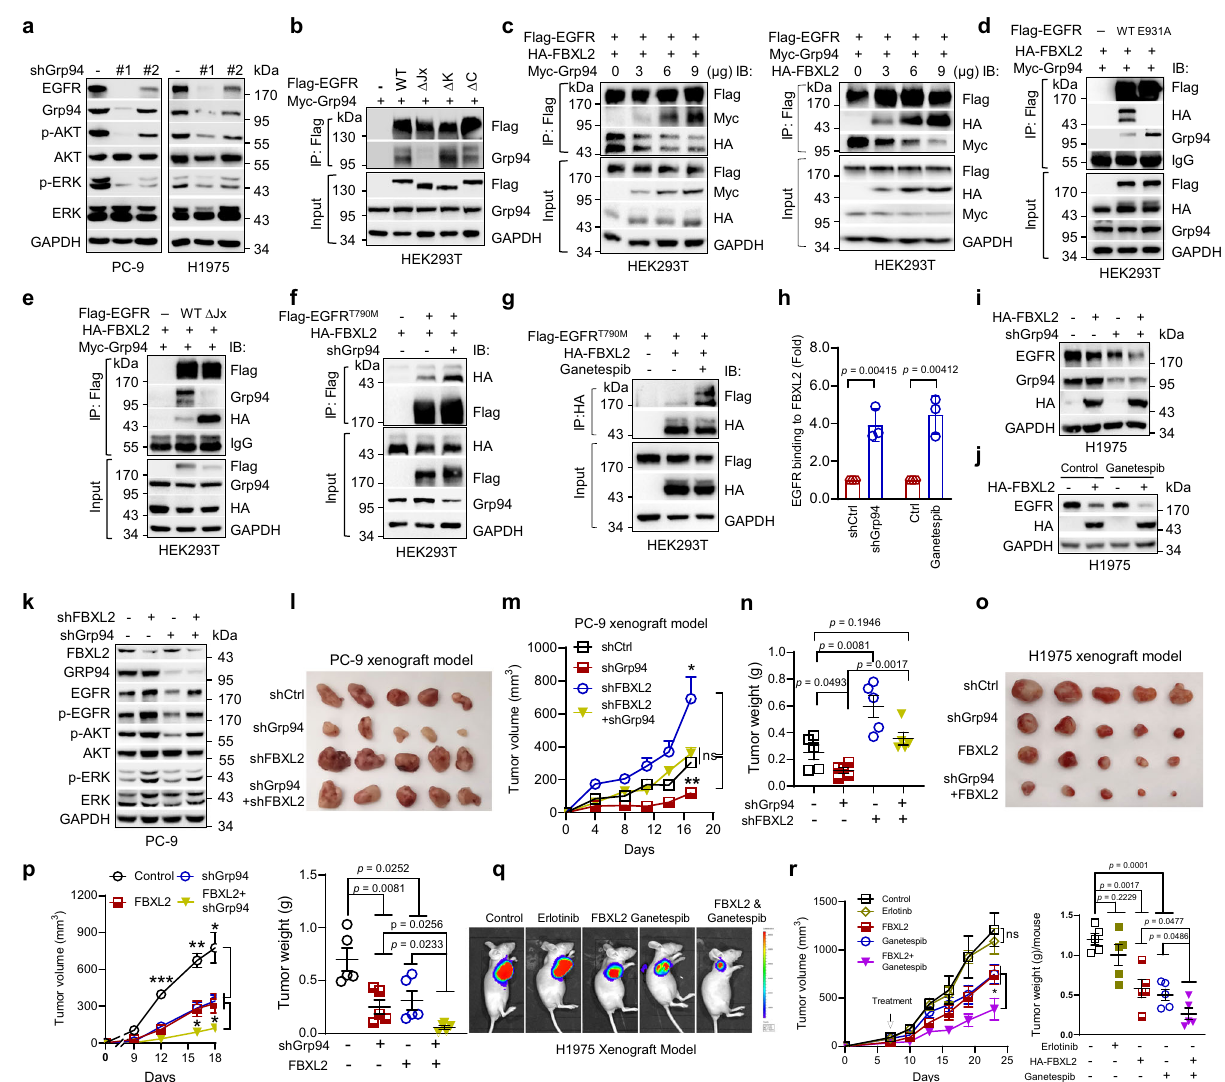
Fig. 5 Grp94 competes with FBXL2 for EGFR binding, and inhibition of Grp94 promotes FBXL2-mediated EGFR degradation in the suppression of TKI- resistant lung tumor growth. a PC-9 or H1975 cells stably expressing shGrp94 were subjected to Western blot analyses. b , c HEK293T cells were co- transfected with indicated expressing plasmids for 36 h. Cells were then treated with MG132 for 4 h, followed by IP-Western analyses. d , e HEK293T cells were co-transfected with HA-FBXL2, Myc-Grp94, and indicated Flag-EGFR expressing plasmids for 36 h. Cells were then treated with MG132 for 4 h, followed by IP-Western analyses. HEK293T cells were co-transfected with Flag-EGFR T790M , HA-FBXL2, and either shCtrl or shGrp94 expressing plasmids overnight ( f ); or HEK293T cells were co-transfected with Flag-EGFR T790M and HA-FBXL2 expressing plasmids overnight and were then treated with or without ganetespib (8 nM) for 12 h ( g ). Cells were treated with MG132 for 4 h prior to IP-Western analyses. The af fi nity of EGFR binding to FBXL2 was quanti fi ed and presented as means ± SD. i H1975 cells stably expressing HA-FBXL2 or shGrp94, or both were subjected to Western blot analyses. j H1975 cells stably expressing HA-FBXL2 were treated with or without ganetespib (8 nM) for 24 h prior to Western blot analyses. PC-9 cells stably expressing either shFBXL2 or shGrp94, or both were subjected to k Western blot analyses or l − n xenograft tumor growth assays ( n = 5/group). Photos of tumors, growth curve, and tumor weight were presented. o , p H1975 cells stably expressing either HA-FBXL2 or shGrp94, or both were subjected to xenograft tumor growth assays ( n = 5/group). Photos of tumors, growth curve, and tumor weight were presented. q , r H1975 cells (5 × 10 5 ) stably expressing HA- FBXL2 or vector were subjected to xenograft tumor growth assays ( n = 5/group). Mice were treated with erlotinib or ganetespib. Representative bioluminescence imaging, growth curve and tumor weight were presented. The experiment was repeated three times independently with similar results ( a − g and i − k ). Data were presented as means ± SEM ( m , n , p , and r ). * p < 0.05, ** p < 0.01, *** p < 0.001; all by two-tailed Student ’ s t -test. Source data are provided as a Source data fi